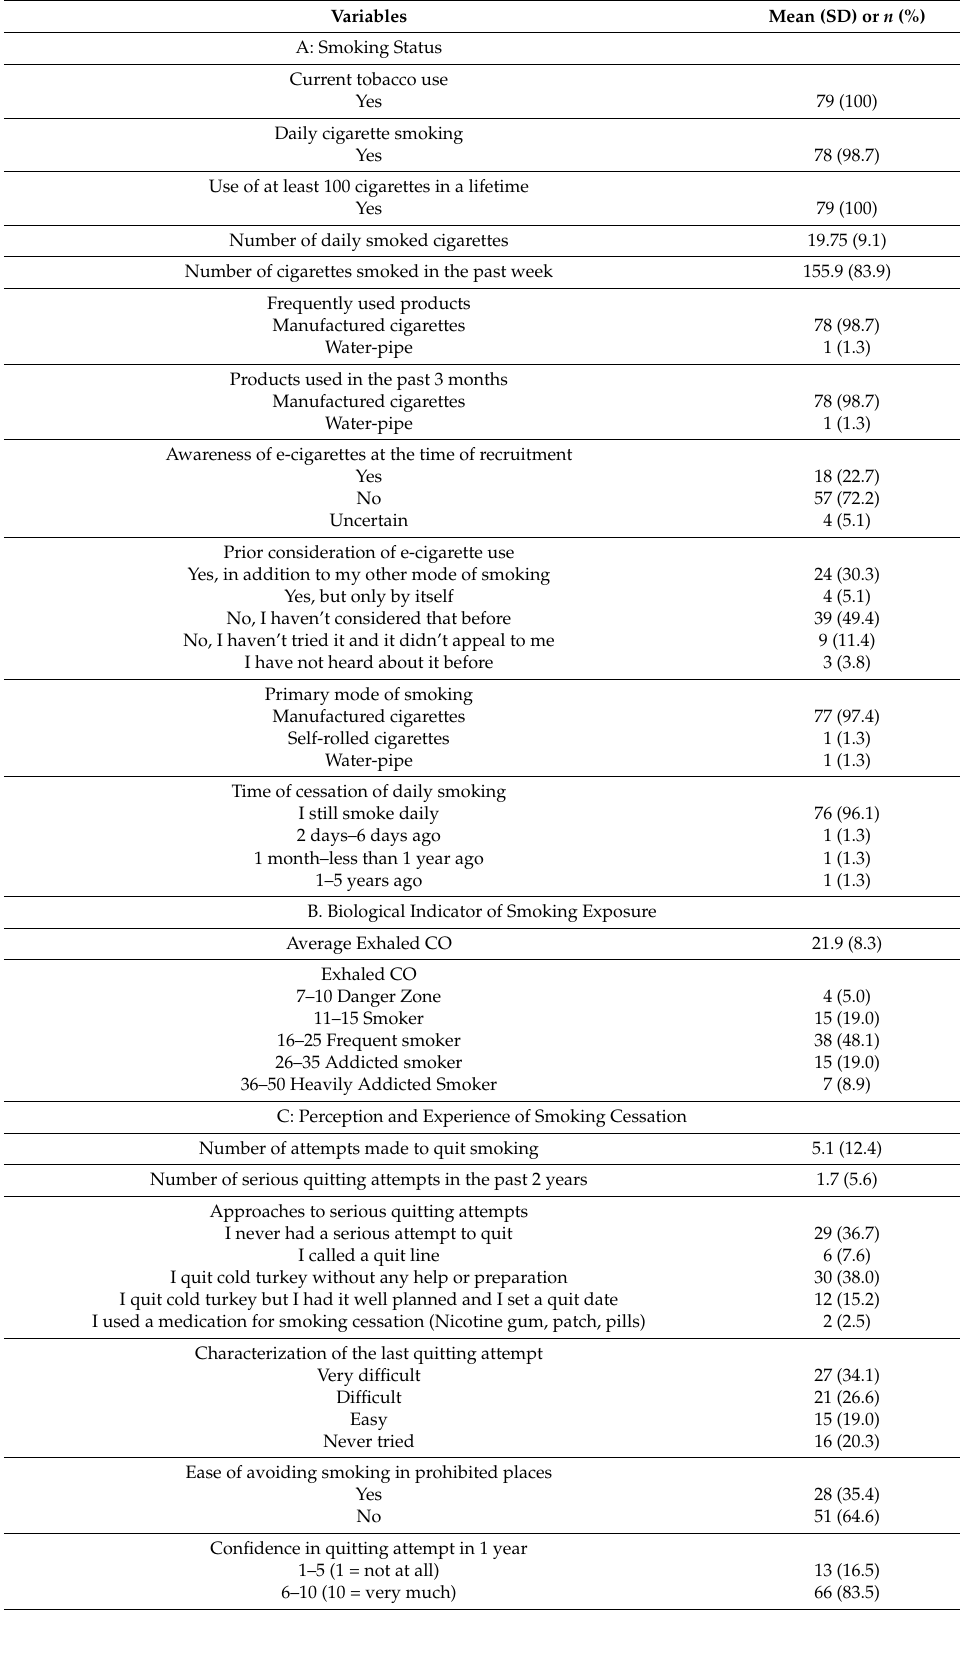
Table 2. Baseline smoking history (N =